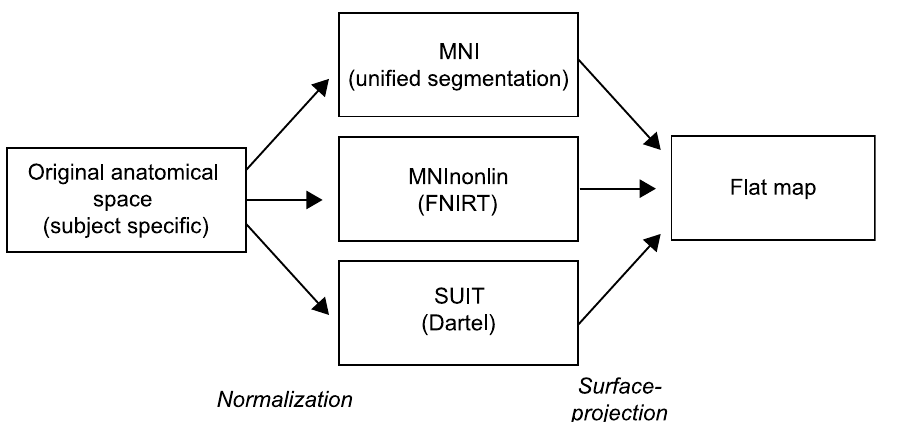
Fig 4. Surface-based mapping pipeline for cerebellar data. Functional data is first normalized using standard volume-based methods and then projected onto the flat representations using corresponding vertices on outer and inner surface. For the process of surface projection, it is therefore important to take into account the type of volume-based normalization algorithm used.